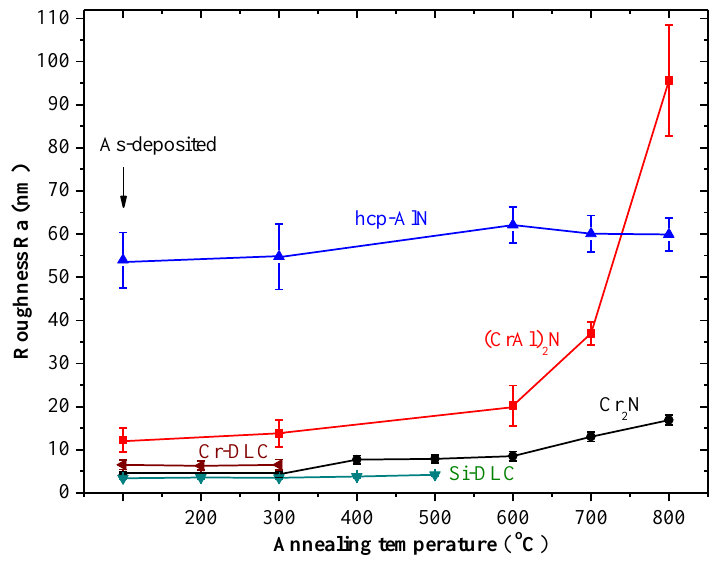
Figure 9. Roughness Ra of the as-deposited and annealed at various temperatures for